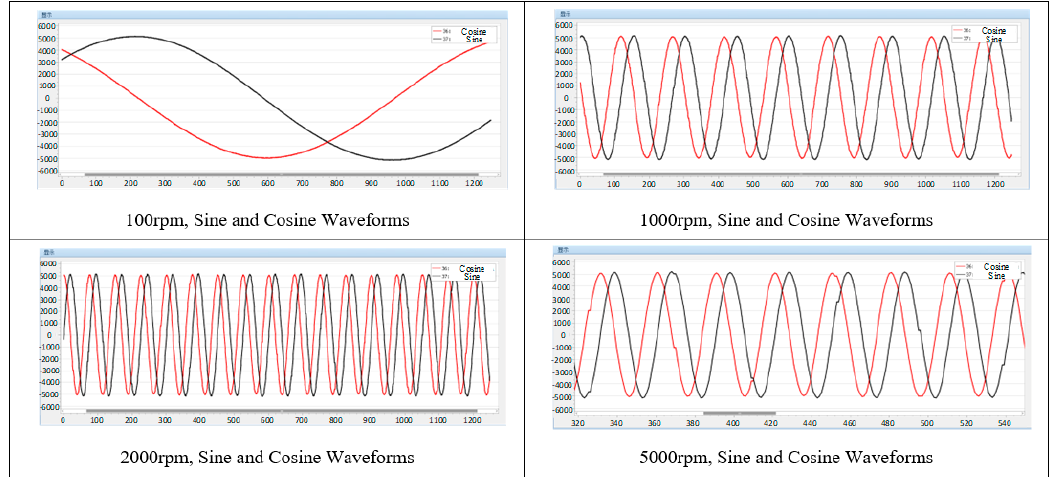
Figure 8. Demodulated sine and cosine waveforms at each rotational speed.